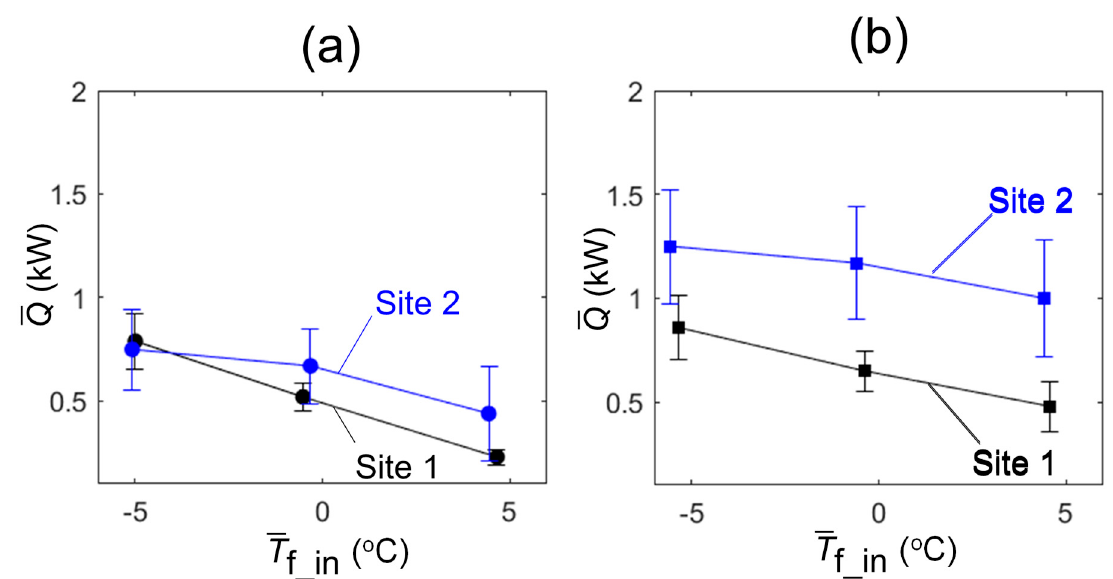
Figure 7. A comparison of heat extraction rates Q for single ( a ) and double heat pipes ( b ) against testing inlet temperatures T f_in for Sites 1 and 2; the bar of each plot denotes the uncertainty 𝛿𝑄 , calculated by Equation (3).